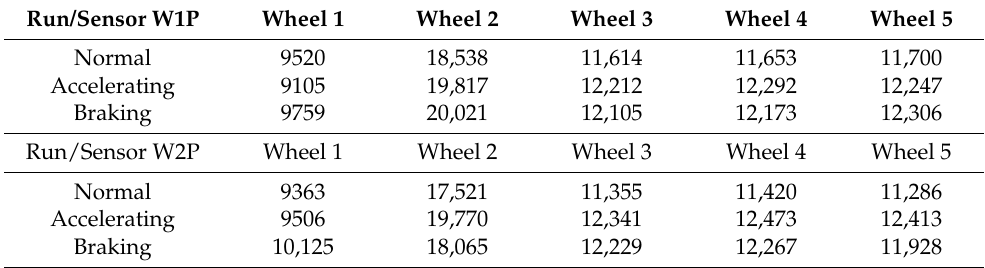
Figure 20. Example signals from the strain gauges sensors W1P and W2P of strain gauges for constant speed, acceleration and braking—five-axle vehicle. Table 8. Strain gauge sensor signal characteristics—signal amplitude (ADU).